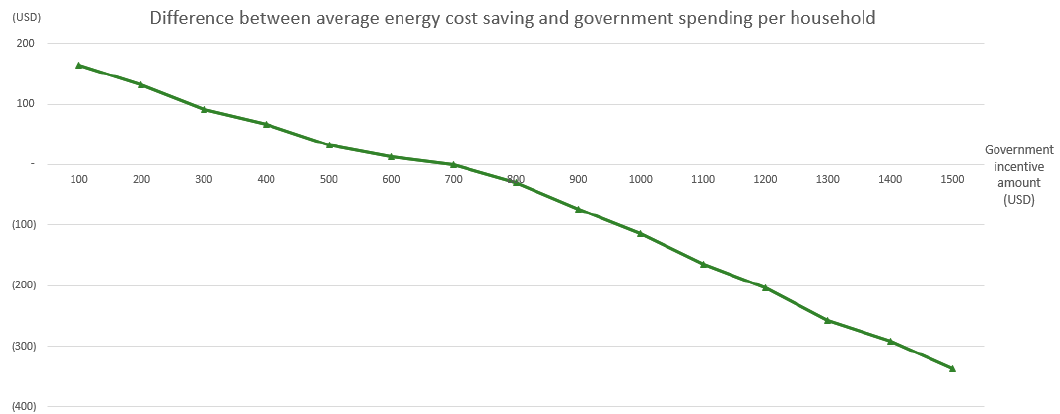
Figure 2. Market scenario analysis for the level of government incentive in promoting purchasing of window sets of energy efficiency level 1.